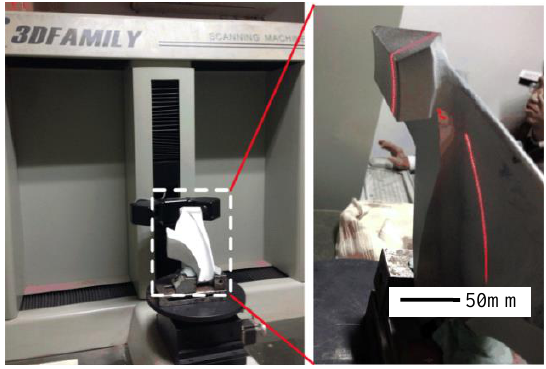
Figure 2. Single blade scanning process.